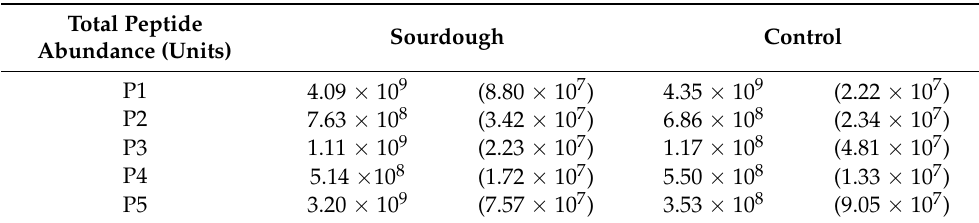
Table 4. The total relative abundance of peptides P1–P5 and their proteolytic products. Brackets display the summed standard